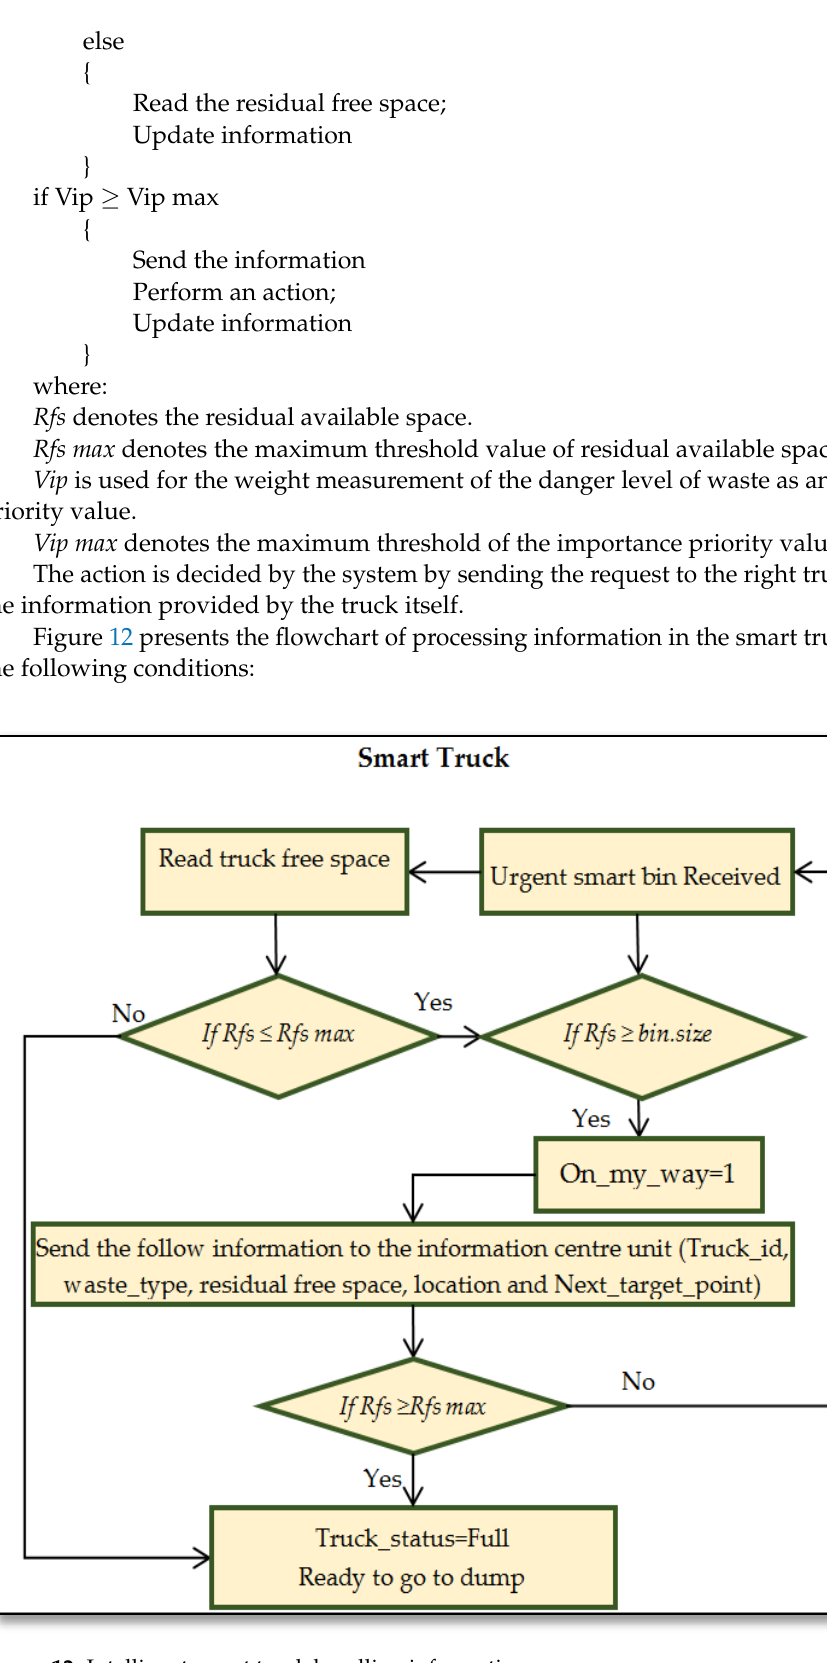
Figure 12. Intelligent smart truck handling information.